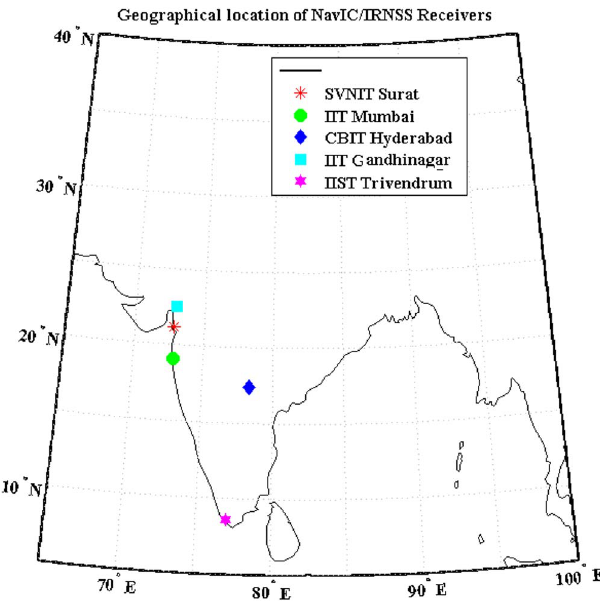
Fig. 4. Observational geographical locations of NavIC/IRNSS receivers.